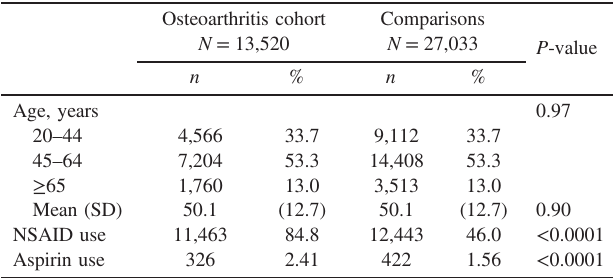
Table 1. Comparison of baseline distributions of age and uses of NSAIDs and aspirin between osteoarthritis cohort and comparison cohort